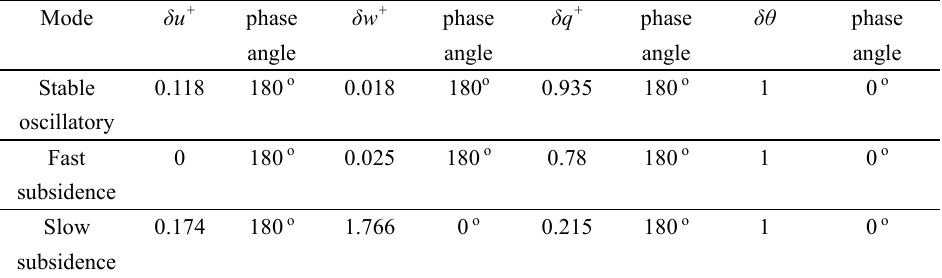
Table 4 Magnitudes and phase angles of each of three